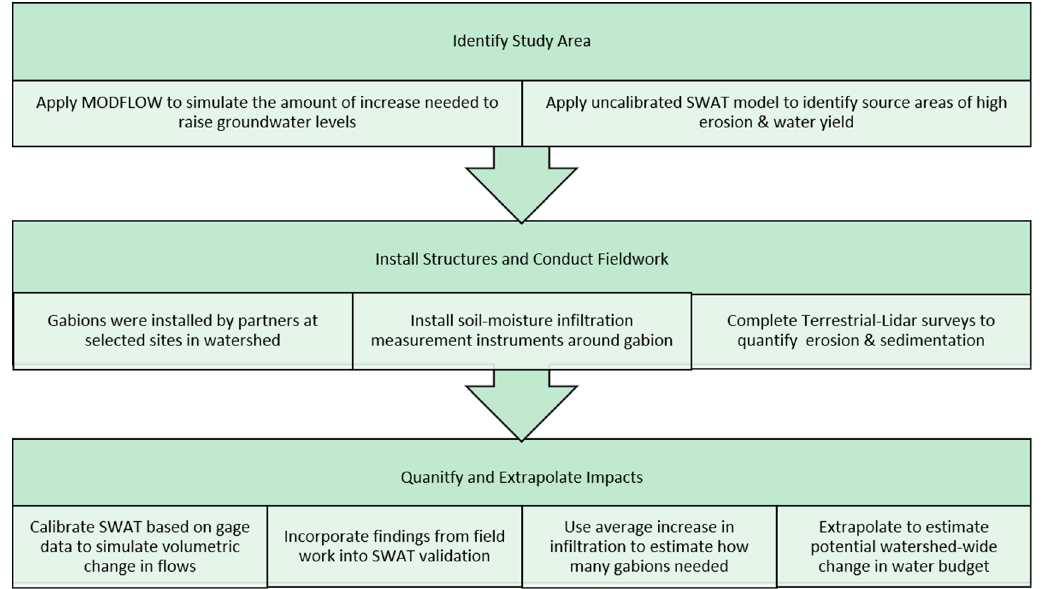
Figure 4. Flow chart describing phases of research and hydrologic model applications.